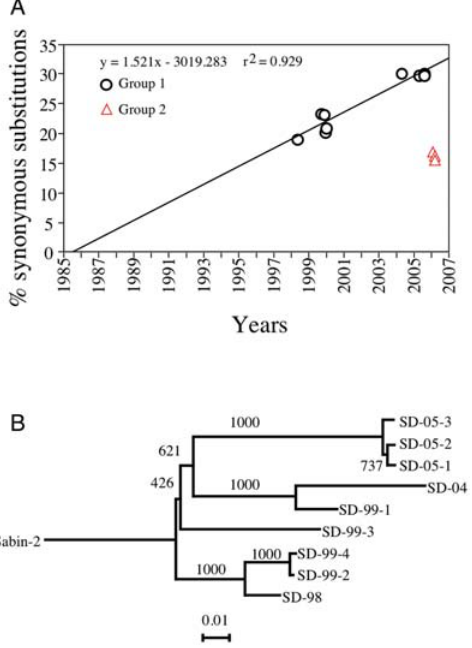
Figure 4. Estimation of the date of initial exposure to Sabin-2. Fig. 4.A. is a method for estimating of the date of initial exposure based on regression analysis of the accumulation of the % of 3 rd position synonymous substitutions from all codons with single nucleotide substitutions in VP1 (region R4 in Fig. 3D). The date of initial exposure to Sabin 2 was determined by extrapolation backwards to 0% substitutions. (r 2 =0.886). Group 1 isolates are represented by open circles while Group 2 Isolates are represented by open triangles. Fig. 4.B is a rooted, neighbor-joining, phylogenetic tree of the same region, region, R4, analyzed in Figs. 3D and 4.A. Unlike Fig. 4.A, substitutions in all three codon positions were taken into account. The tree was prepared with ClustalX. Data was bootstrapped 1000 times. The numbers on the branches are the bootstrap values. The tree was visualized using the njplot program. Branch lengths correspond to genetic distances. Since dates of isolation are know, branch lengths were converted to time. The time for the distance between Sabin 2 and the first branch was calculated proportionally to the minimum and maximum branch ‘‘times’’ between different pairs of